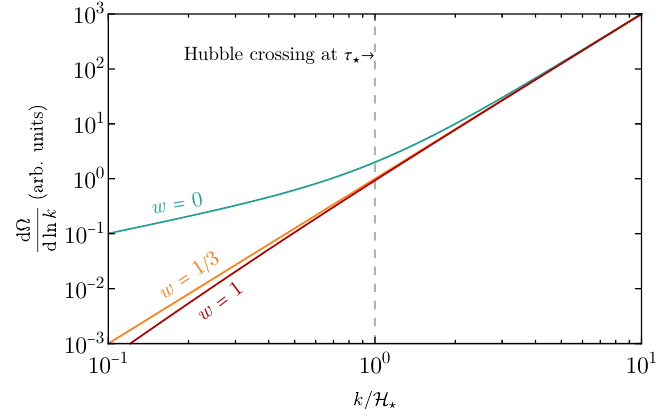
Figure 1 . Plot of the scaling of dΩ gw / d log k versus k for different equations of state w . The different cosmologies are all normalized so that their sub-horizon modes are of the same size in order to emphasize their super-horizon